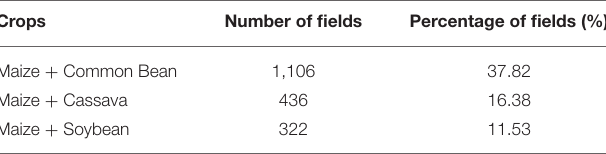
TABLE 3 | Number of fields intercropped with two or more other crops in season